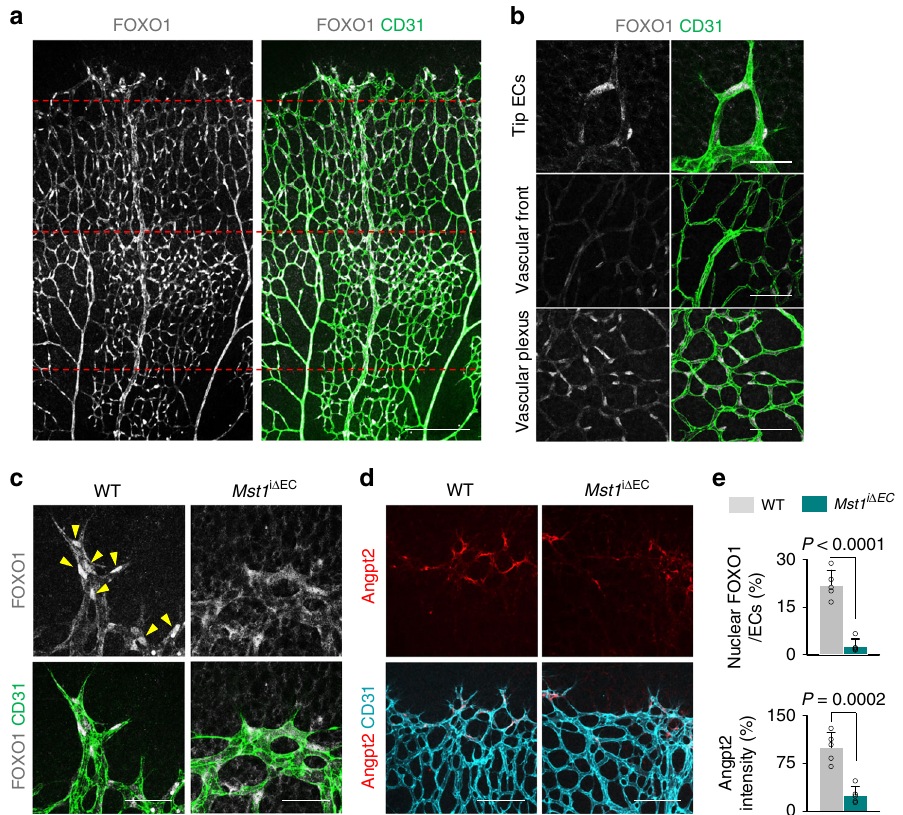
Fig. 3 MST1 regulates nuclear localization of FOXO1 at tip ECs. a Images of CD31 + retinal vessels and distribution of FOXO1 of whole retina in WT mouse at P6. The red dashed lines separate into tip ECs, vascular front and vascular plexus from top to bottom. Scale bars, 200 μ m. b Magni fi ed images of CD31 + vessels and subcellular localization of FOXO1 at indicated portions. Scale bars, 50 μ m. c Magni fi ed images of the nuclear localization of FOXO1 (yellow arrowheads) at tip ECs in WT and Mst1 i Δ EC mice. Scale bars, 50 μ m. d Images of angiopoietin-2 (Angpt2) expression and CD31 + vessels at vascular front in WT and Mst1 i Δ EC mice. Scale bars, 100 μ m. e Comparisons of indicated parameters in WT ( n = 5) and Mst1 i Δ EC ( n = 5) mice. Data represent mean (bar) ± s.d. (error bars). P values, versus WT by two-tailed unpaired t -test. NS not signi fi cant. Source data are provided as a Source Data fi